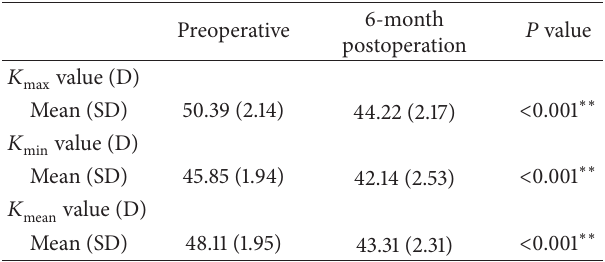
Table 5: General satisfaction of participants 6 months after opera-